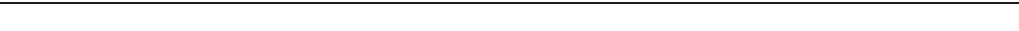
Fig. 6 T2-MZP Bregs mediate suppression via iNKT cells and require CD1d. a Top, schematic showing the experimental design. Bottom, bar chart showing suppression of knee swelling in Cd1d − / − and WT mice that received T2-MZP B cells, isolated from the spleens of WT mice on day 7 post disease onset, compared to Cd1d − / − and WT mice that received no transfer ( Cd1d − / − n = 11, WT n = 16, one of two experiments is shown). b Representative fl ow cytometry plots (left) and bar charts (right) showing the frequency and number of splenic IFN- γ + and IL-17 + CD4 + T cells in Cd1d − / − and WT mice that received T2-MZP B cells, isolated from the spleens of WT mice on day 7 post disease onset, or Cd1d − / − and WT mice that received no transfer ( n = 3 per group, one of two experiments is shown). c Top, schematic showing the experimental design. Bottom, mean clinical score of WT mice that received T2- MZP B cells, isolated from the spleens of J α 18 − / − or WT mice on day 7 post disease onset, or WT mice that received no transfer following induction of arthritis. The Y axis shows the percentage of swelling in antigen-injected knee compared to control knee ( J α 18 − / − T2-MZP transfer n = 4, WT T2-MZP transfer n = 3, no transfer n = 4, one of two experiments is shown). d Representative fl ow cytometry plots (top) and bar charts (bottom) showing the frequency and number of splenic IFN- γ + and IL-17 + CD4 + T cells in WT mice that received T2-MZP B cells, isolated from the spleens of J α 18 − / − or WT mice on day 7 post disease onset, or WT mice that received no transfer ( n = 4 per group, one of two experiments is shown). e Top, schematic showing the experimental design. Bottom, mean clinical score of WT mice that received T2-MZP B cells, isolated from the spleens of Cd1d − / − or WT mice on day 7 post disease onset, or WT mice that received no transfer following induction of arthritis. The Y axis shows the percentage of swelling in antigen-injected knee compared to control knee ( n = 6 per group, one of two experiments is shown). f Representative fl ow cytometry plots (top) and bar charts (bottom) showing the frequency and number of splenic IFN- γ + and IL-17 + CD4 + T cells in WT mice that received T2-MZP B cells, isolated from the spleens of Cd1d − / − or WT mice on day 7 post disease onset, or WT mice that received no transfer ( n = 4 per group, one of two experiments is shown). g Representative fl ow cytometry plots and bar chart showing the frequency of IFN- γ + splenic iNKT cells in WT mice that received T2-MZP B cells, isolated from the spleens of Cd1d − / − or WT mice on day 7 post disease onset, or WT mice that received no transfer ( n = 4 per group, one of two experiments is shown). b , d , f , g Analyzed on day 3 post disease onset. Data are mean ± s.e.m. ns not signi fi cant, * p < 0.05, ** p < 0.01, *** p < 0.001, **** p < 0.0001, (cid:129)(cid:129) p < 0.01, and (cid:129)(cid:129)(cid:129) p